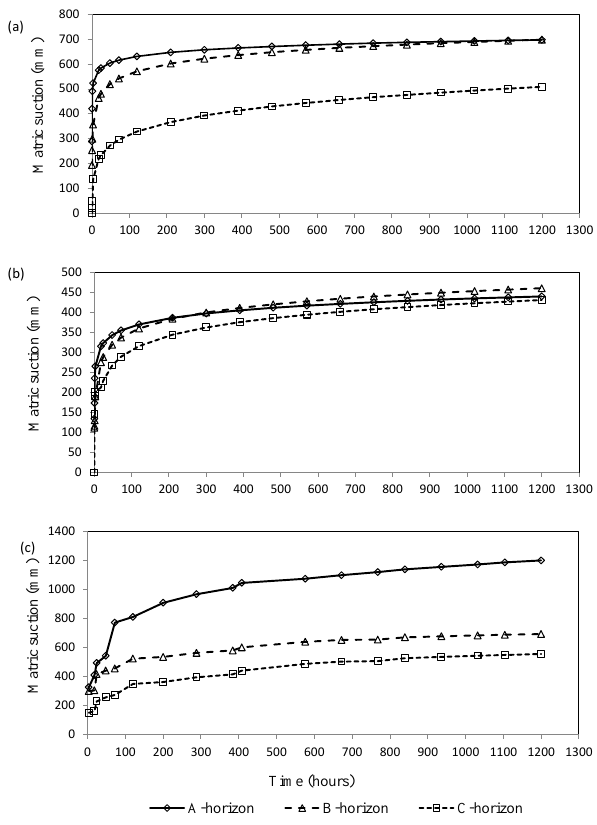
Figure 3 Estimated matric suction using van Genuchten (1980) Model for the Tukulu (a), Fig. 3. Estimated matric suction by applying the van Sepane (b) and Swartland (c) diagnostic horizons for internal drainage conditions Genuchten (1980) model fitted retention curve directly to measured drainage soil water content for the Tukulu, Sepane and Swartland diagnostic